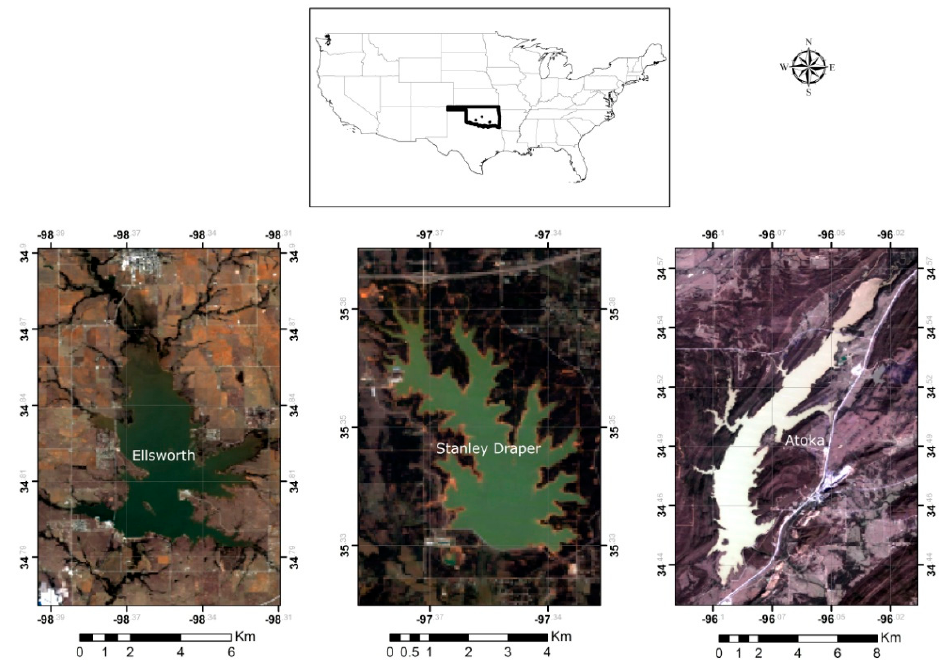
Figure 2. Location of Oklahoma water reservoirs in the United States.